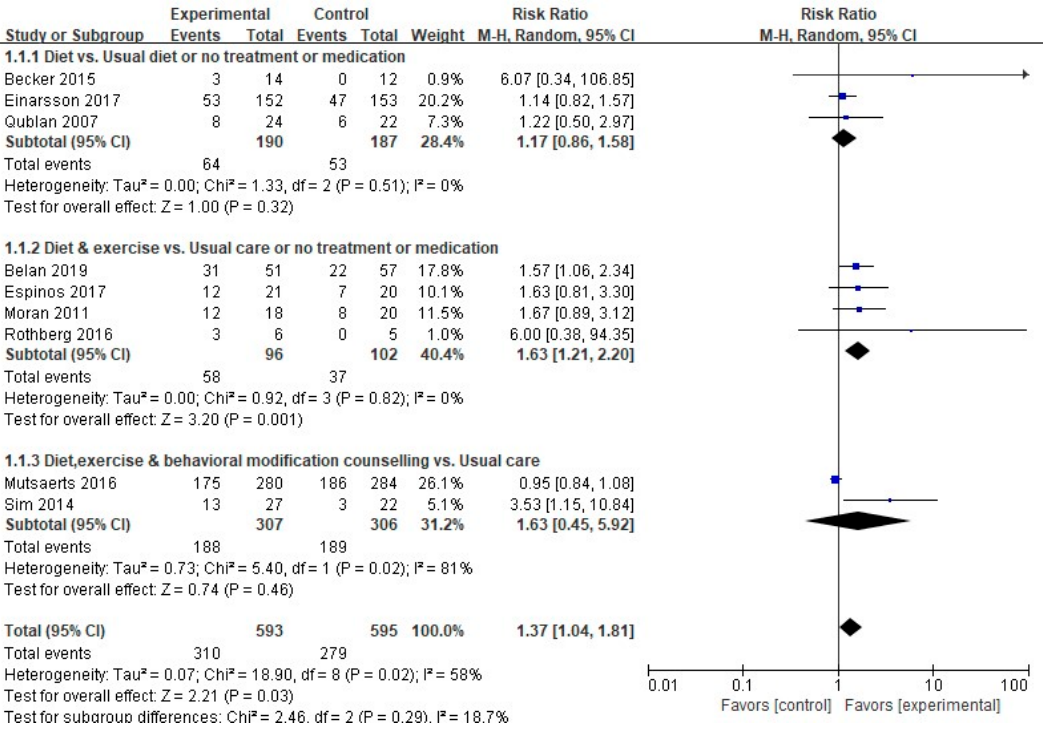
Figure 4. Forest plot of non-pharmacological intervention on pregnancy rate. M-H, the Mantel-Haenszel method; Random, random effects model; CI, confidence interval.